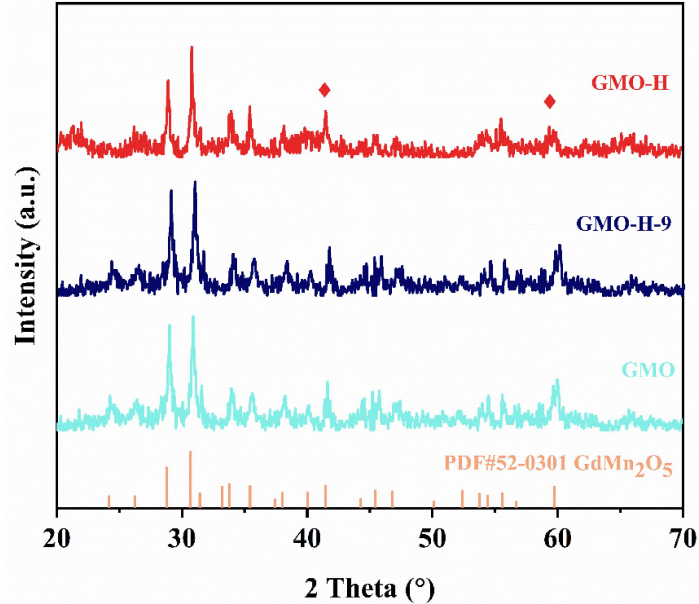
Figure 1. XRD patterns of GMO, GMO-H-9, and